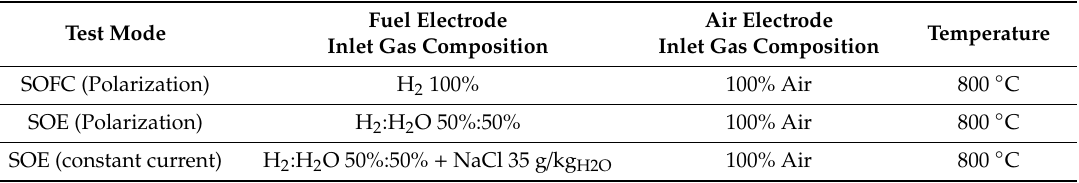
Table 1. Compositions and operating conditions of the cell in SOE and SOFC mode.